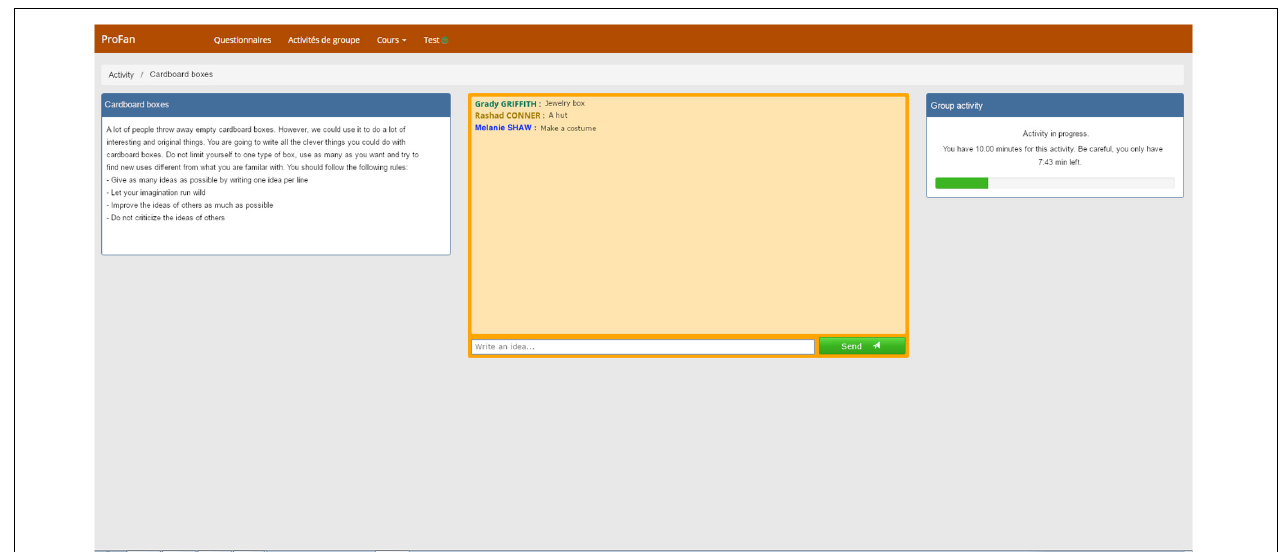
FIGURE 1 | Screenshot of the synchronous electronic brainstorming